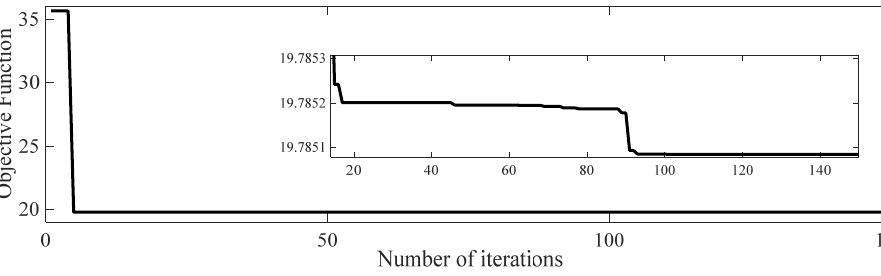
Figure 5. The best transient response of the rotor speed gives as a result the MFOA.